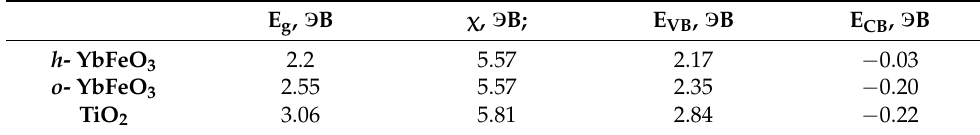
Table 2. Parameters of the electronic structure of o -YbFeO 3 / h -YbFeO 3 /TiO 2 nanocomposite.